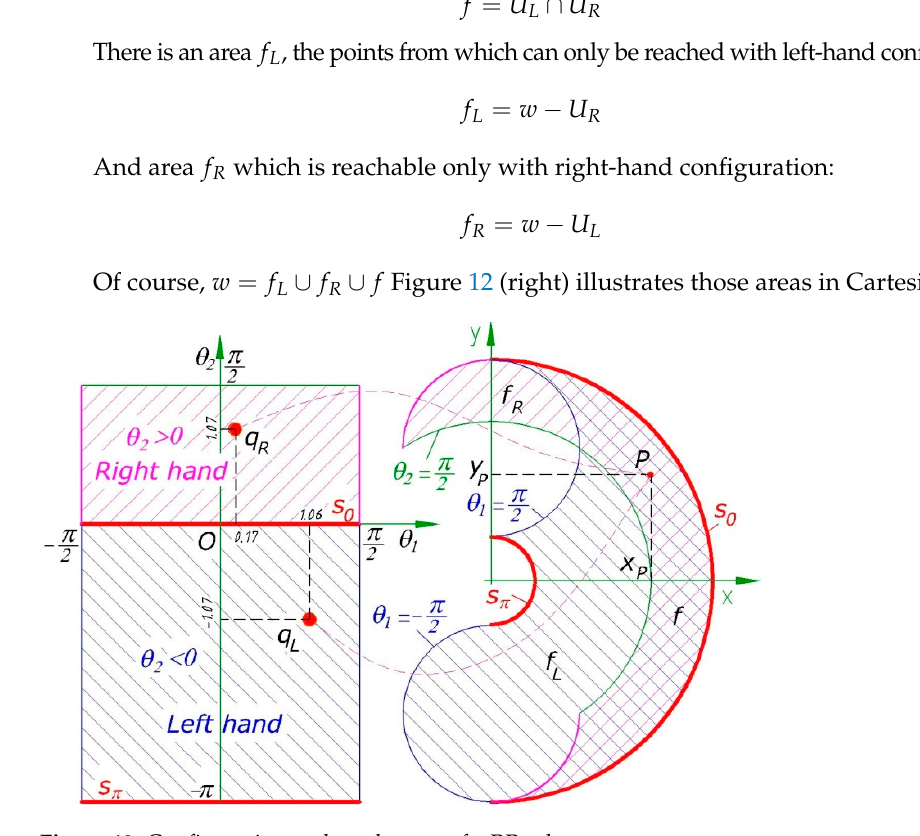
Figure 11. ( а ) 3D printed model of a SCARA type robot; ( b ) Reachability area with left- and right- hand configuration and workspace.